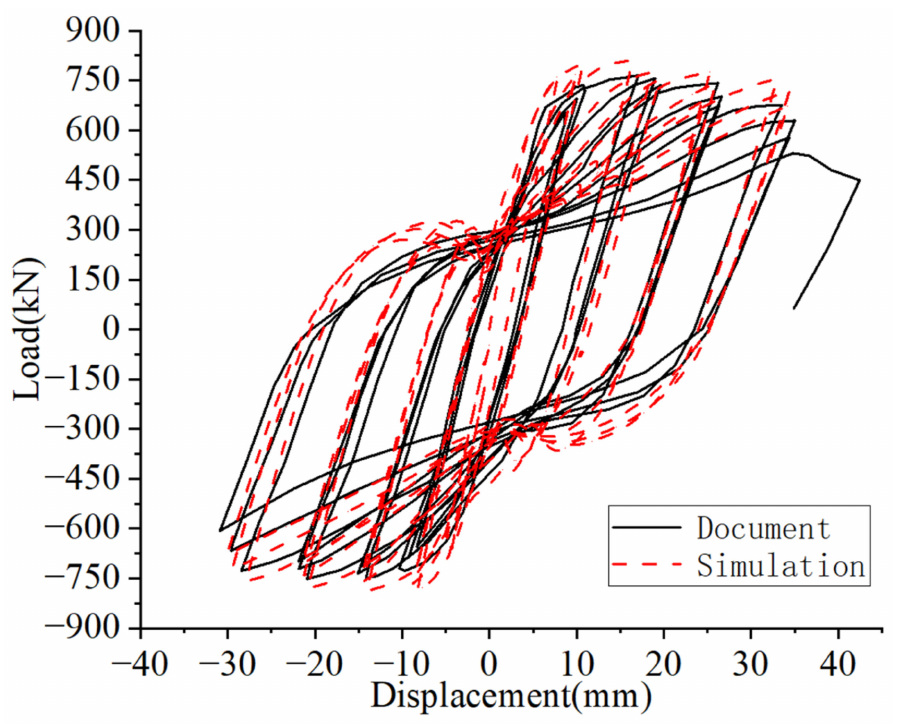
Figure 4. Hysteretic loading